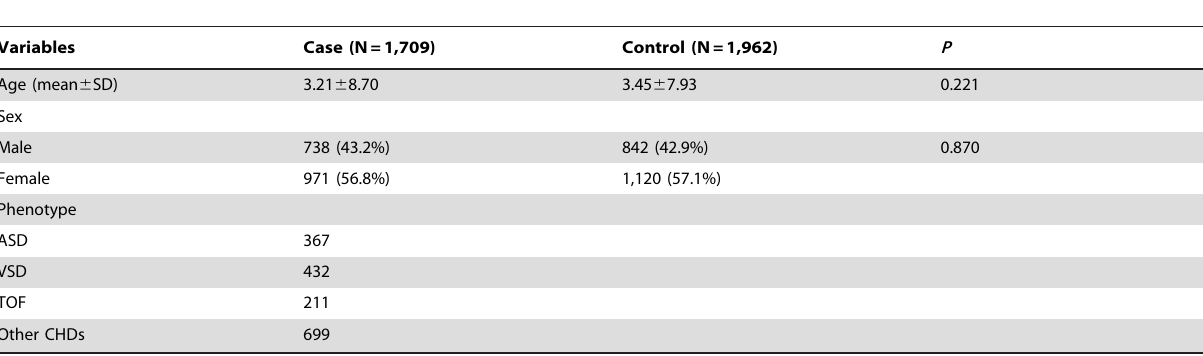
Table 2. Characteristics of CHD cases in validation